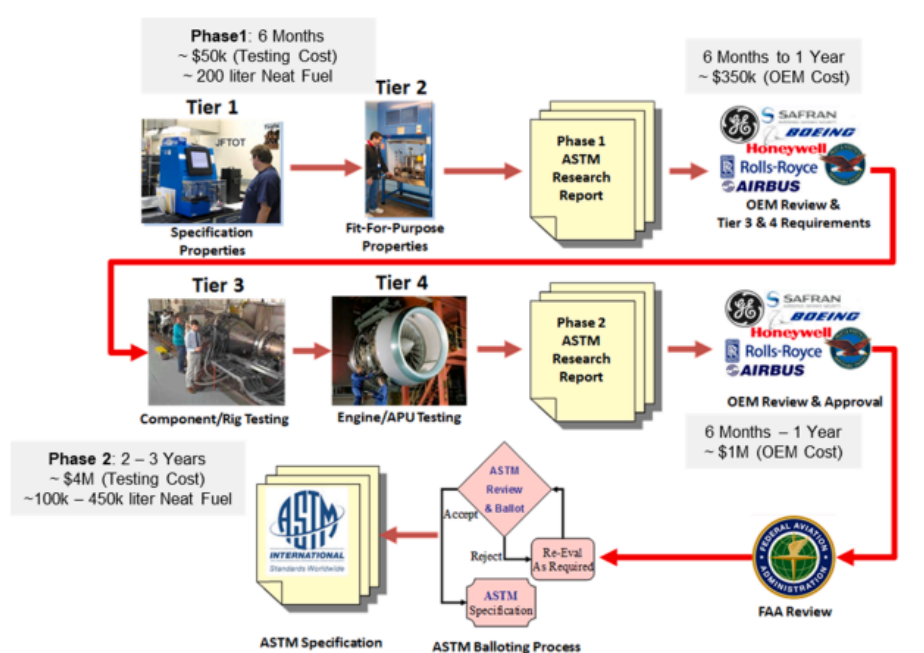
Figure 4. A nominal ASTM D4054 evaluation process with fuel and cost requirements, not including the cost of fuel production [37].